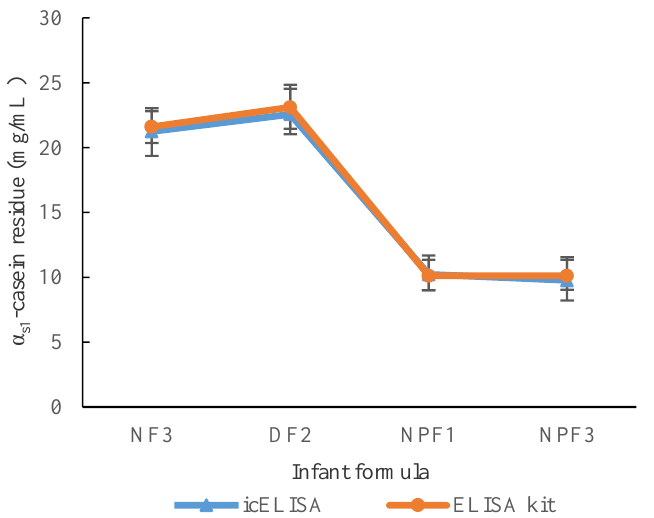
Figure 9. α s1 -casein residue in commercial infant formula using the established ic-ELISA method or α s1 -casein ELISAkit .